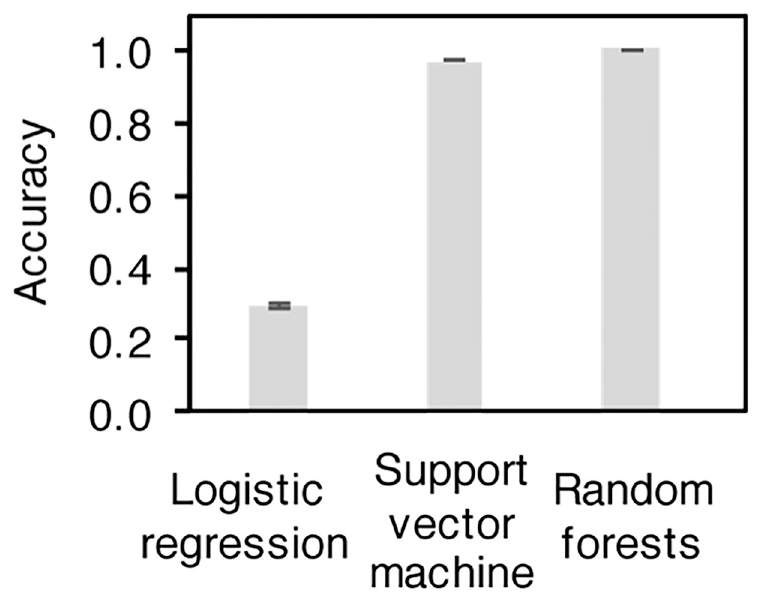
Fig 2. Classifier performance of models utilizing gut microbiome taxon